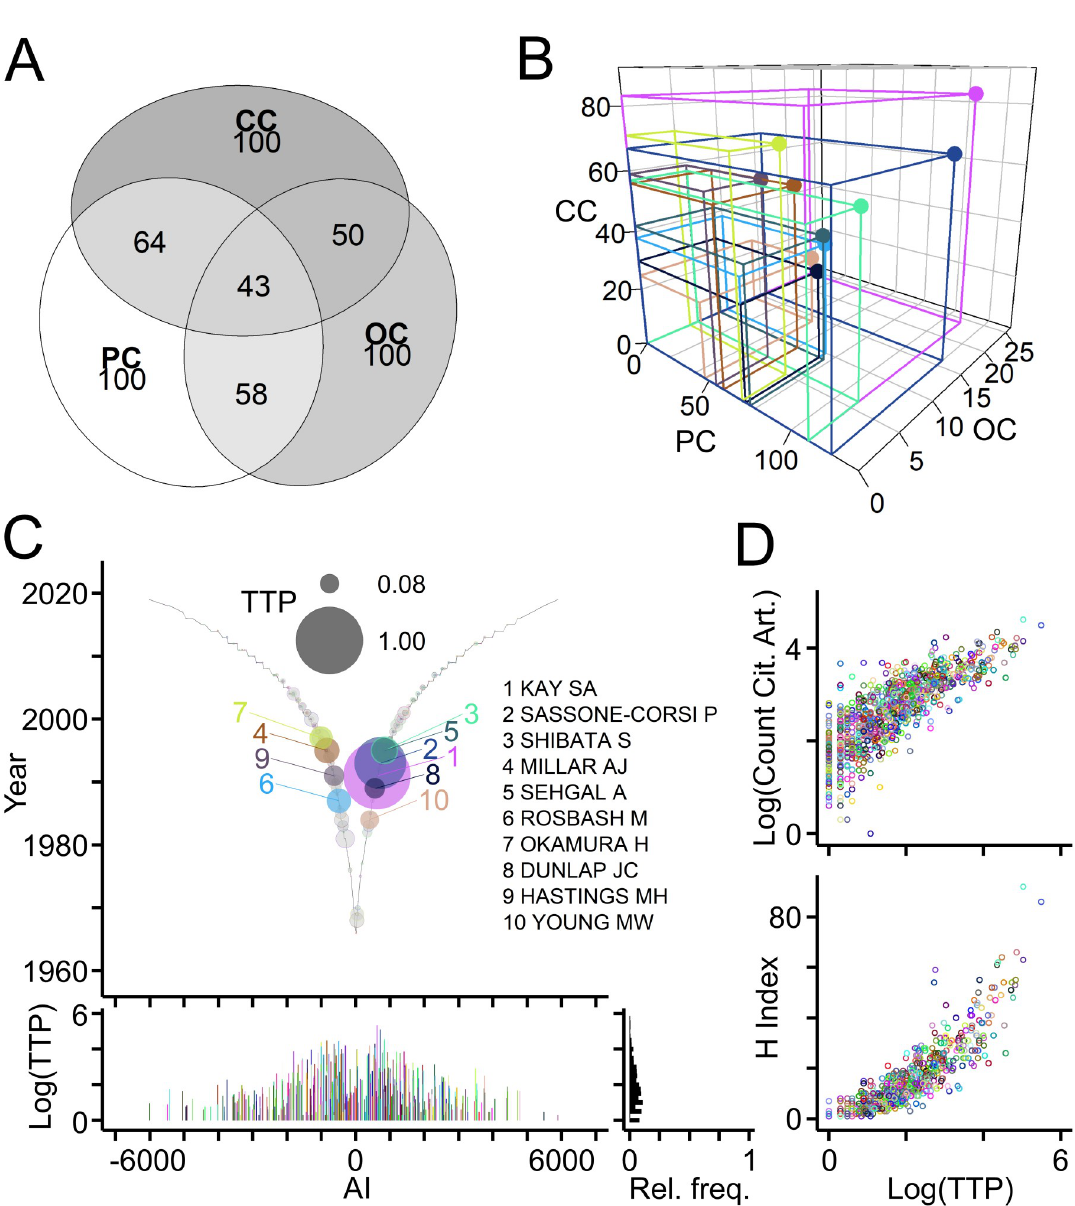
Fig 7. Introduction of TeamTree product as new measure of scientific production. (A) Numbers of intersecting authors in the Clock field ranking among top 100 for each parameter (PC, OC, CC). (B) Scatterplot of indicated parameters for authors with top ten TeamTree product (TTP) values calculated as the volume occupied by each author (PC × OC × CC). (C) Top, graph showing the TTP of authors in the Clock field with colored circles and names indicating authors with ten highest values. Grey circles with colored border indicate authors with TTP values above zero. Circle size indicates log10(TTP) normalized to maximum. Bottom, log10(TTP) values and their relative frequency distribution. (D) Scatterplots, where circles represent individual authors (indicated by color) with their total number of citing articles (top; log10 values) and their H indices (bottom) plotted against their TTP (log10 values).